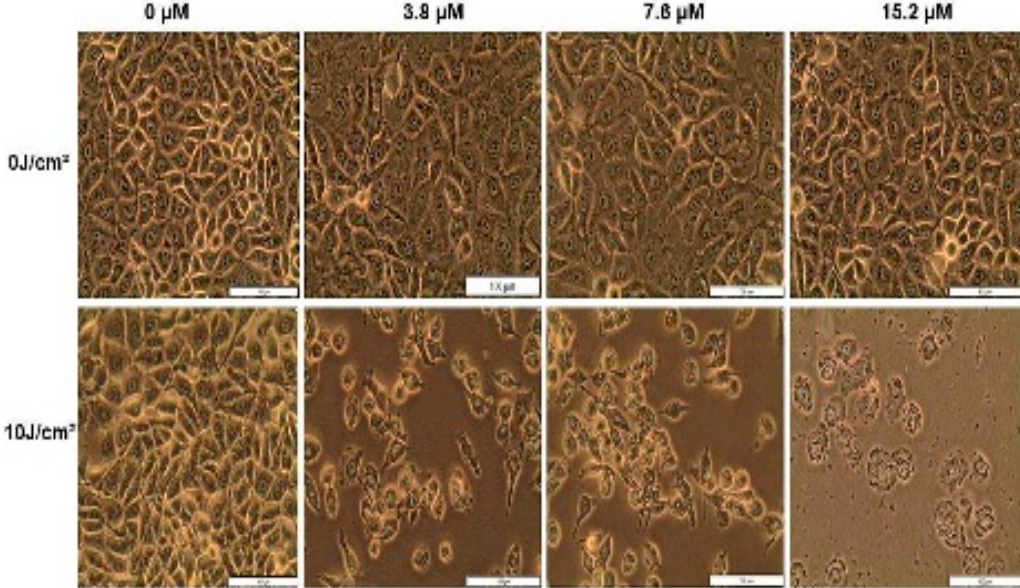
Figure 6. Morphology at 12 h post Hyp-AuNP compound PDT treatment.